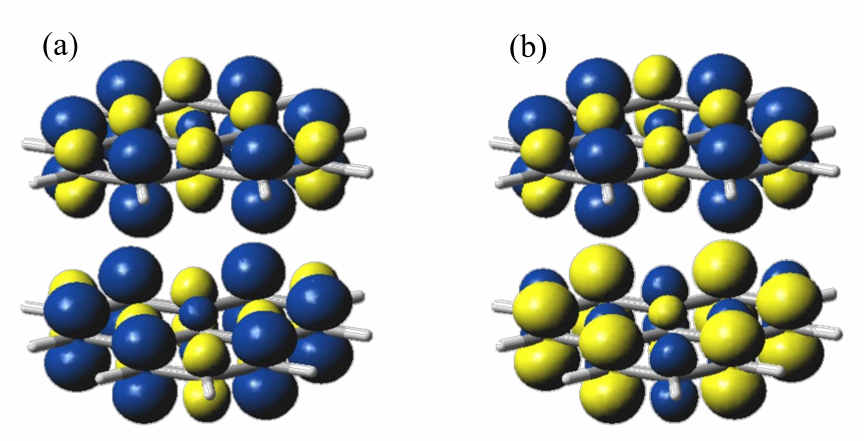
Figure 4. The spin density maps for ( a ) HS and ( b ) BS configurations of the phenalenyl dimer in staggered conformation ( D 3d symmetry). The blue surfaces stand for α spin density and yellow for the β